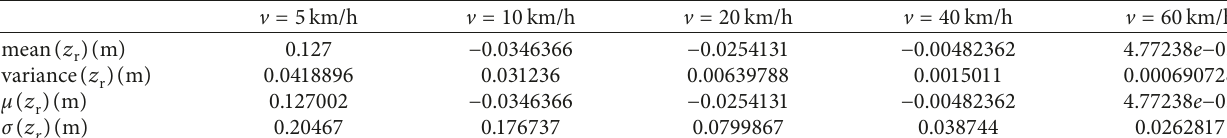
by velocity of the car. r by the velocity of the car for the road profile shown in Figure r